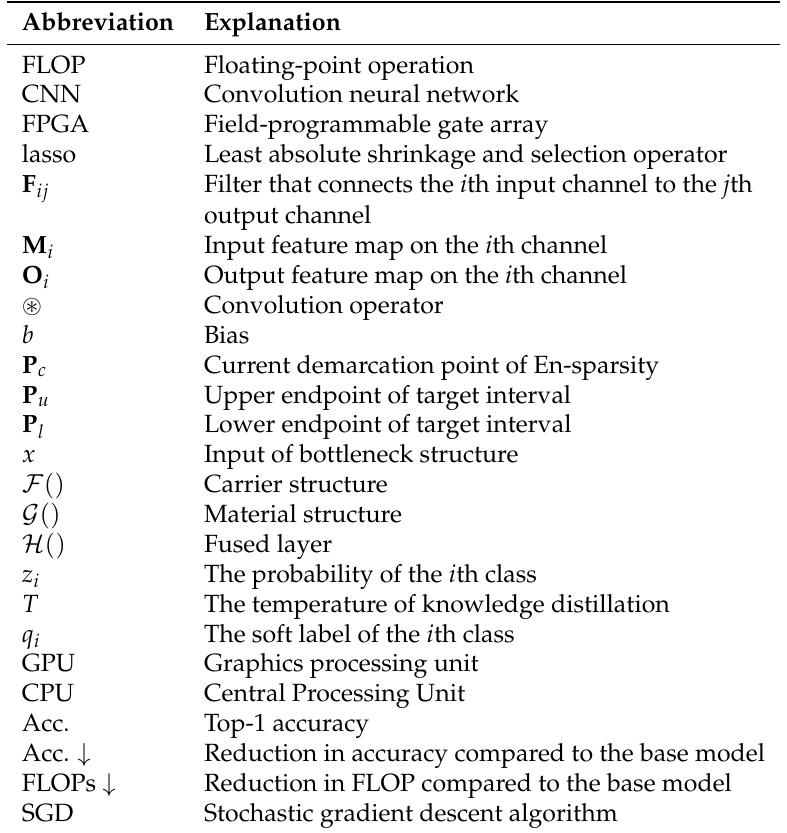
Table A1. List of abbreviations and